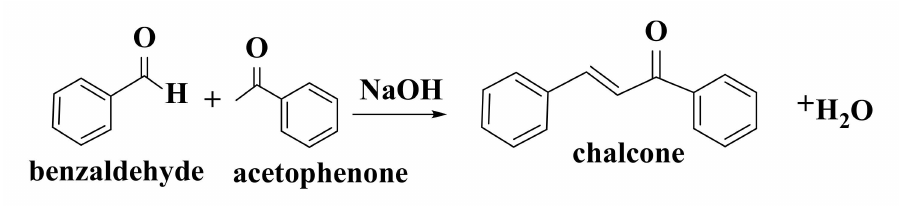
Figure 6. Claisen–Schmidt reaction.